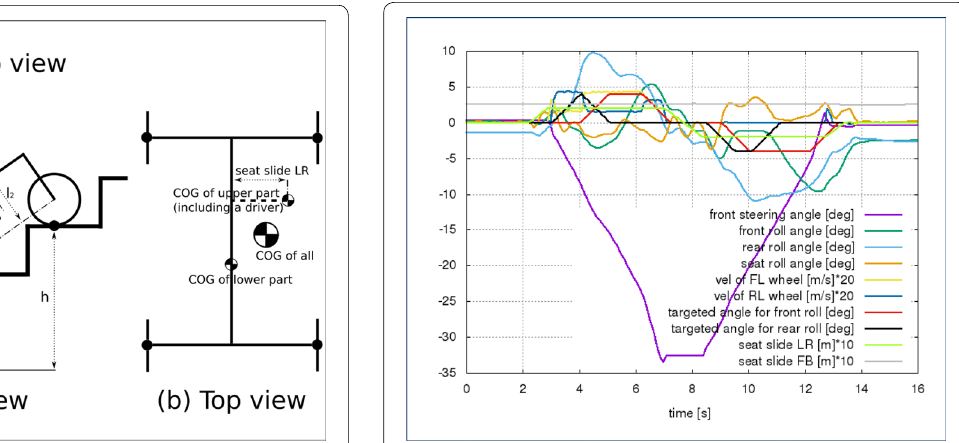
Fig. 7 Experimental setup